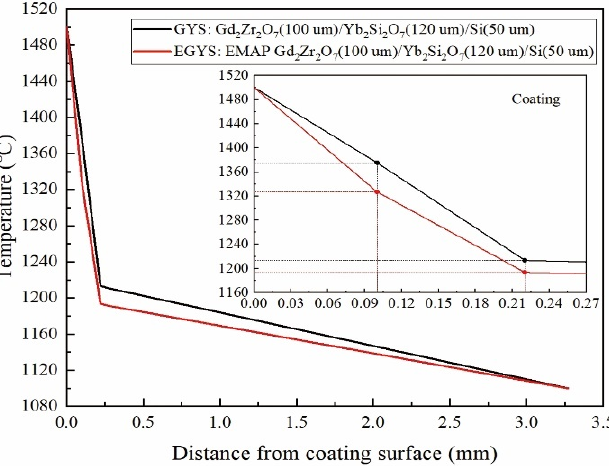
Figure 6. Temperature distributions along the right boundary path during heat preservation period (inset picture is a magnification of the coating section).